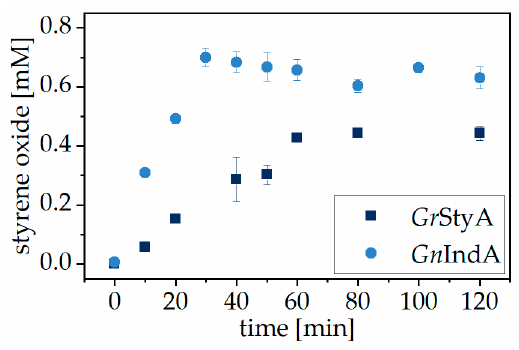
Figure 4. Formation of styrene oxide under optimal conditions (20 mM Tris-HCl pH 7.5, 2 mM styrene, 1 mM dithiothreitol, 5 vol.% glycerol, 20 U/mL catalase and 10 vol.% MeOH for Gn IndA or 5 vol.% DMSO for Gr StyA): Gn IndA produces 0.70 ± 0.03 mM styrene oxide within 30 min